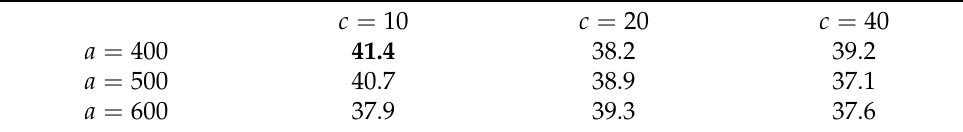
Table 3. Further calibration of M1: the geometric mean of the PCS across scenario 2.1, 2.2, 6.1, 6.2 for various values of hyper-parameters a = 400,500,600, and c = 10,20,40. The highest PCS is in bold. Results are based on 500